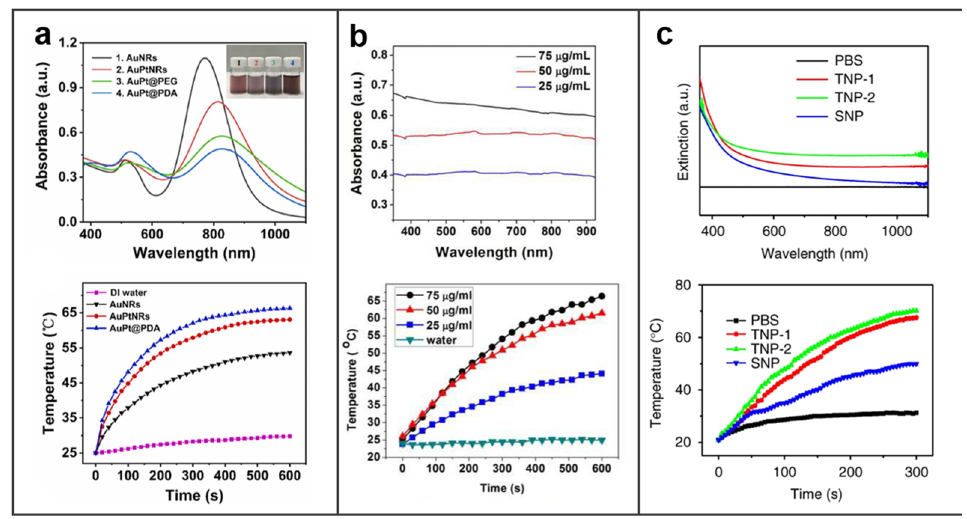
Figure 3. Photothermal effect of BMNs. ( a ) UV/vis absorption spectra and temperature curves of NPs. Reprinted with permission from Ref. [74]. Copyright © 2022 Elsevier B.V. ( b ) UV/vis-NIR absorption spectra and photothermal effects of the aqueous dispersion of PEGylated Au@Pt NDs. Reprinted with permission from Ref. [62]. Copyright © 2016 American Chemical Society. ( c ) UV/vis spectrum and temperature changes of CuPd NPs in aqueous solution. Reprinted with permission from Ref. [63]. Copyright © 2022 Springer Nature Limited.